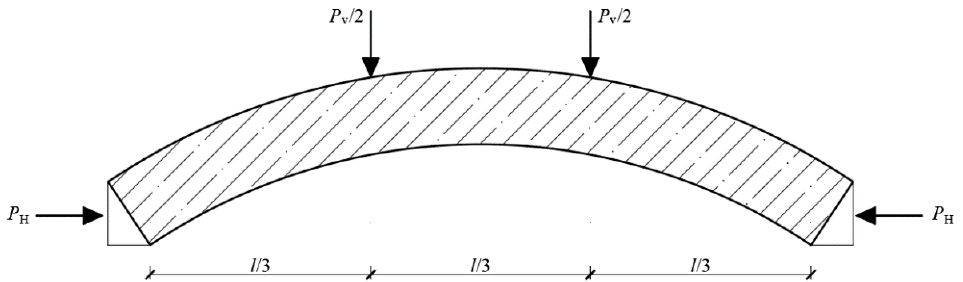
Figure 3. Loading method. Figure 3. Loading